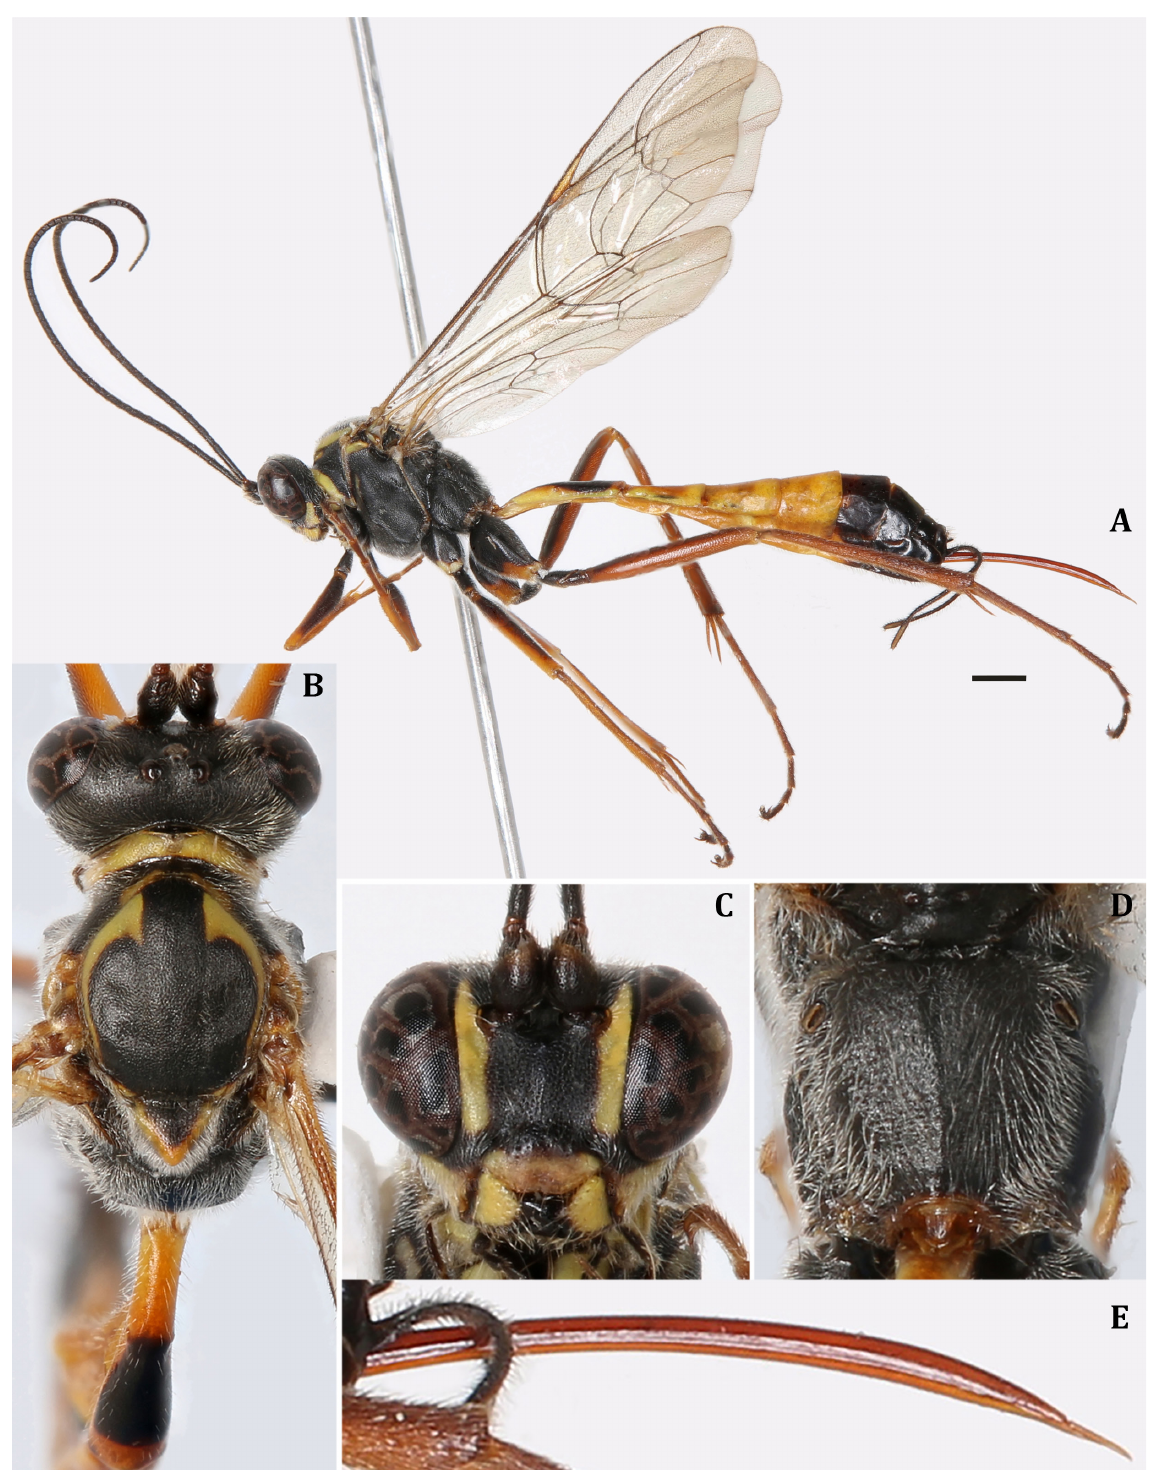
Fig. 3. Exetastes tullu sp. nov. holotype, ♀ (MUSM). A . Habitus, in lateral view. B . Head, mesosoma and T1 in dorsal view. C . Face. D . Propodeum. E . Ovipositor. B–F not to